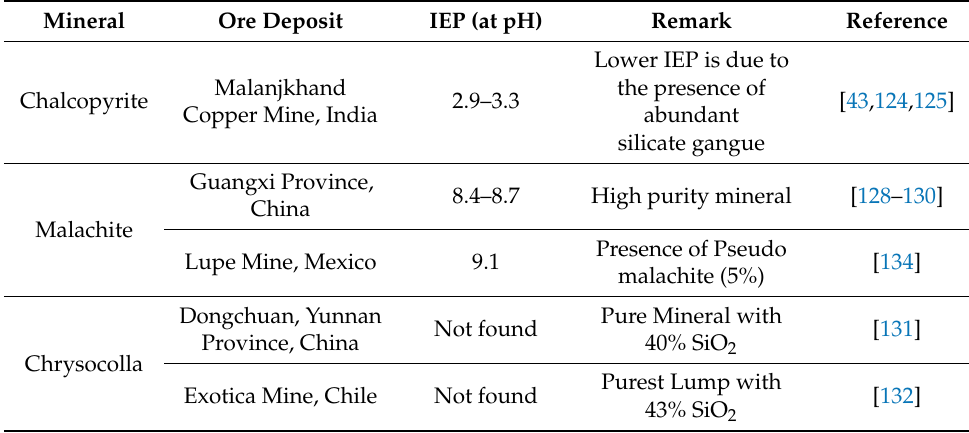
Table 10. Iso Electric Points (IEP) of different copper